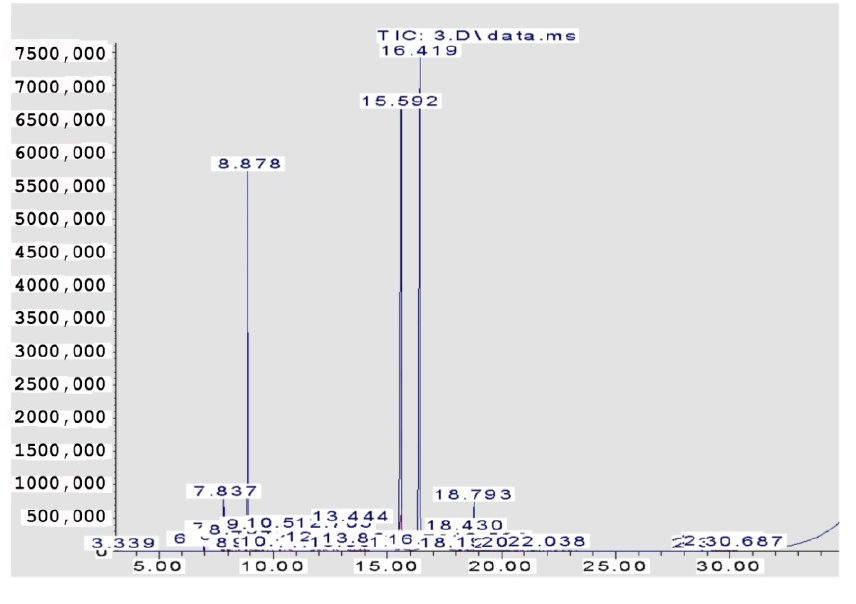
Figure 1. GC Chromatogram of C. clementina (SFME).